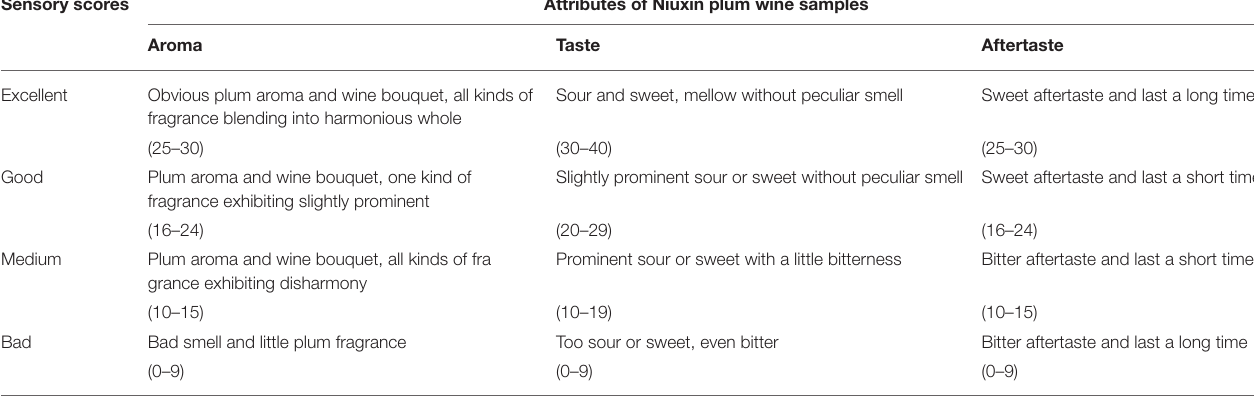
TABLE 2 | Sensory evaluation standard of Niuxin plum